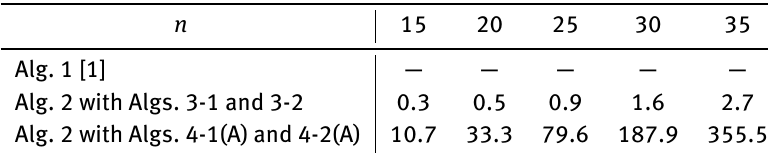
Table 9: Required times (sec) of Algorithms 1 and 2 for T with random matrices A , B , C and the size of T is n 3 × n 3 . The symbol “—” means that the algorithm did not converge to the minimum singular values of T